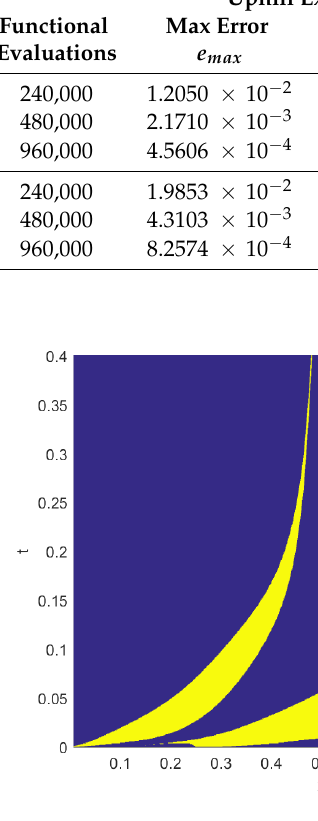
Figure 5. Regions in the space-time domain where N 2 and ∂ x u 2 have the same